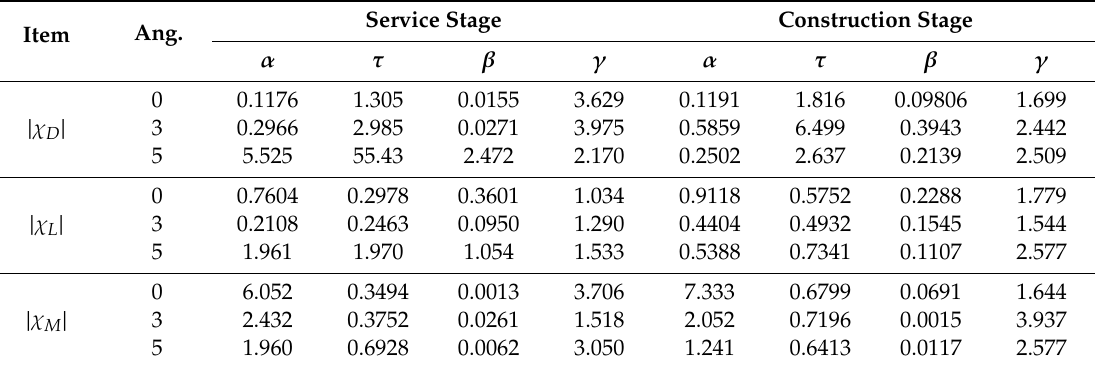
Table 4. Main parameters identified in fitting AAFs by Equation (13) at di ff erent stages.